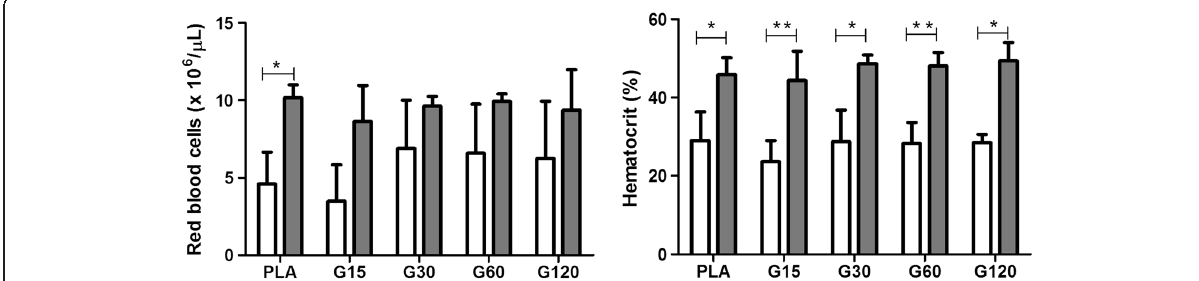
Figure 1 Effects of different doses of MVIIC on red blood cells (× 10 6 / μ L) and hematocrit. Mean number± SD of red blood cells and hematocrit of rats submitted to compressive spinal cord injury and treated with placebo (PLA, positive control) or ω -conotoxin MVIIC (G15, 15 pmol MVIIC; G30, 30 pmol MVIIC; G60, 60 pmol MVIIC), preoperatively (white column) and eight days after treatment (gray column) (* p < 0.05; ** p < 0.01). Red blood cells and hematocrit normal values are, respectively, 7.62 - 9.99 × 10 6 / μ L and 38.5-52%, as described by Giknis and Clifford